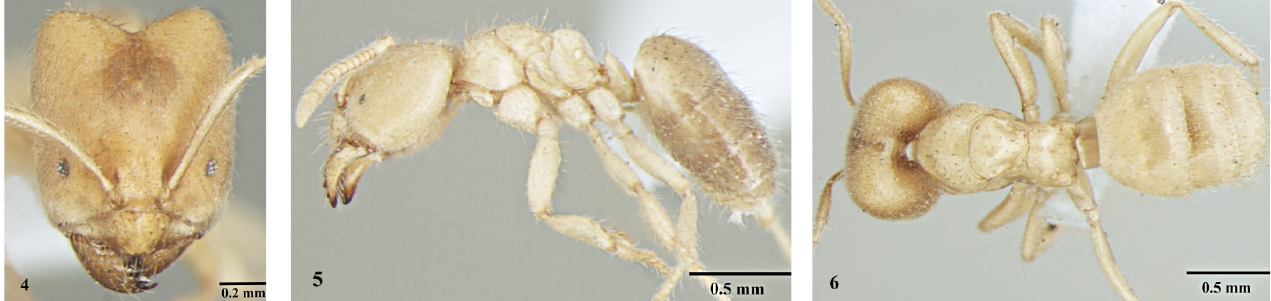
Fig. 4-6. Pseudolasius diversus sp. n . , media worker 4) head, full face view; 5) body lateral view; 6) body, dorsal view.